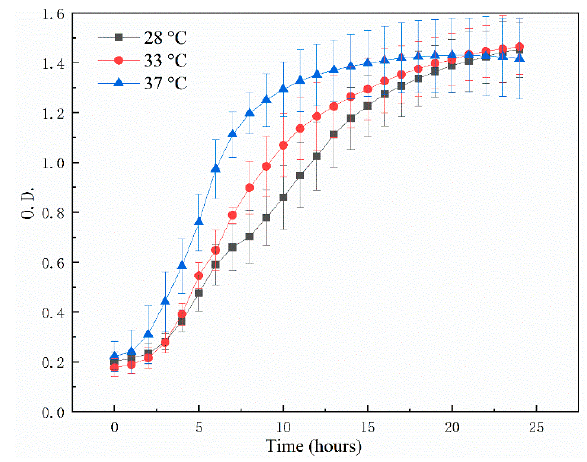
Figure 2. The growth ability of L. plantarum CAU 3823 at different temperatures (28 °C, 33 °C and 37 ◦ C). Growth curves are representative of all °C). Growth curves are representative of all determinations. 37